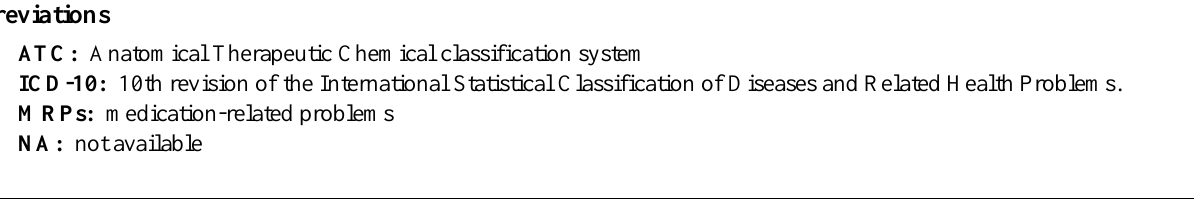
ATC: Anatomical Therapeutic Chemical classification system ICD-10: 10th revision of the International Statistical Classification of Diseases and Related Health